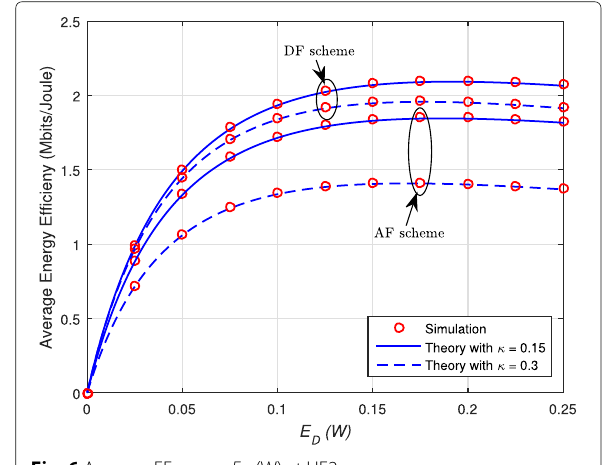
Fig. 6 Average EE versus E D (W) at